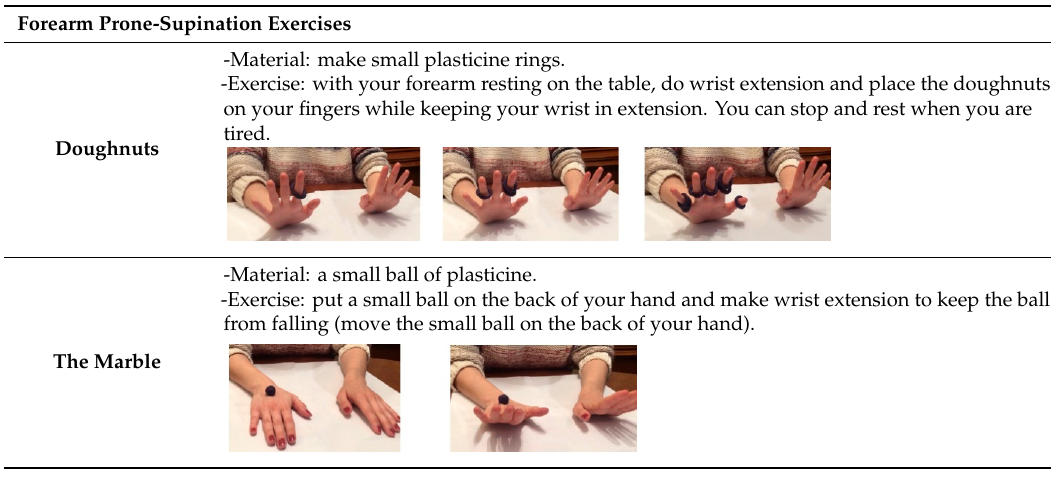
Table 2. Examples of each session per week for 4 weeks of treatment (Conventional Mirror Therapy (MT) or Virtual Reality MT).